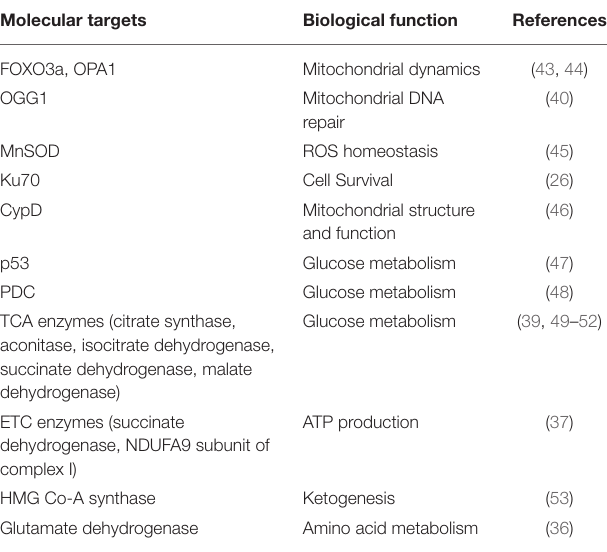
TABLE 1 | SIRT3 targets and their biological